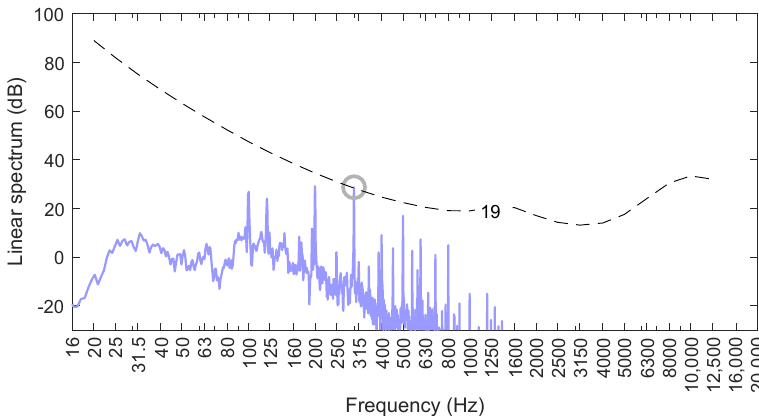
Figure 19. Predicted narrow band sound pressure spectrum at the receiver after the installation of the baffled